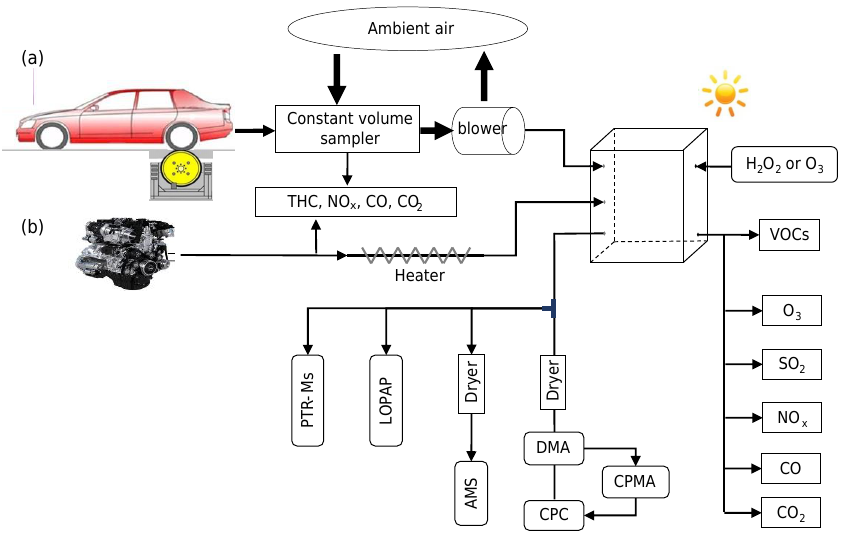
Figure 1. Schematic diagram of chamber experiments.